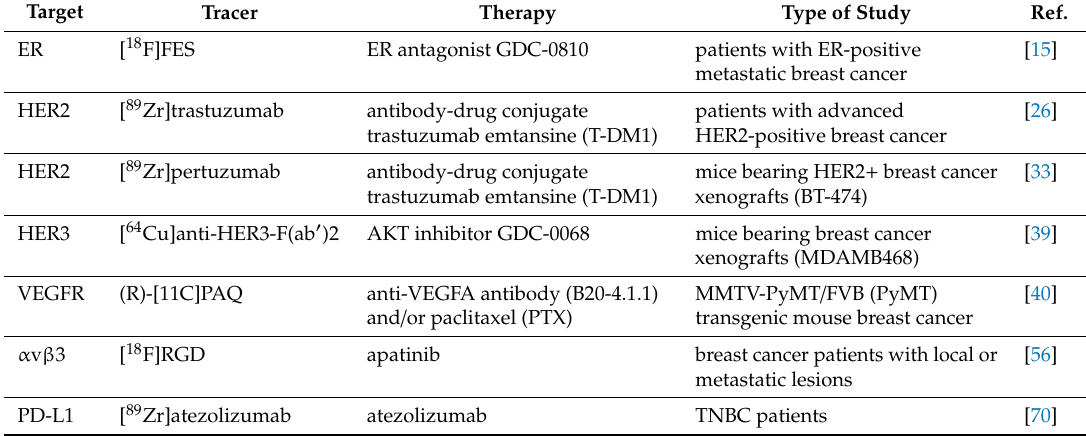
Table 2. Molecular Imaging for targeted therapy response